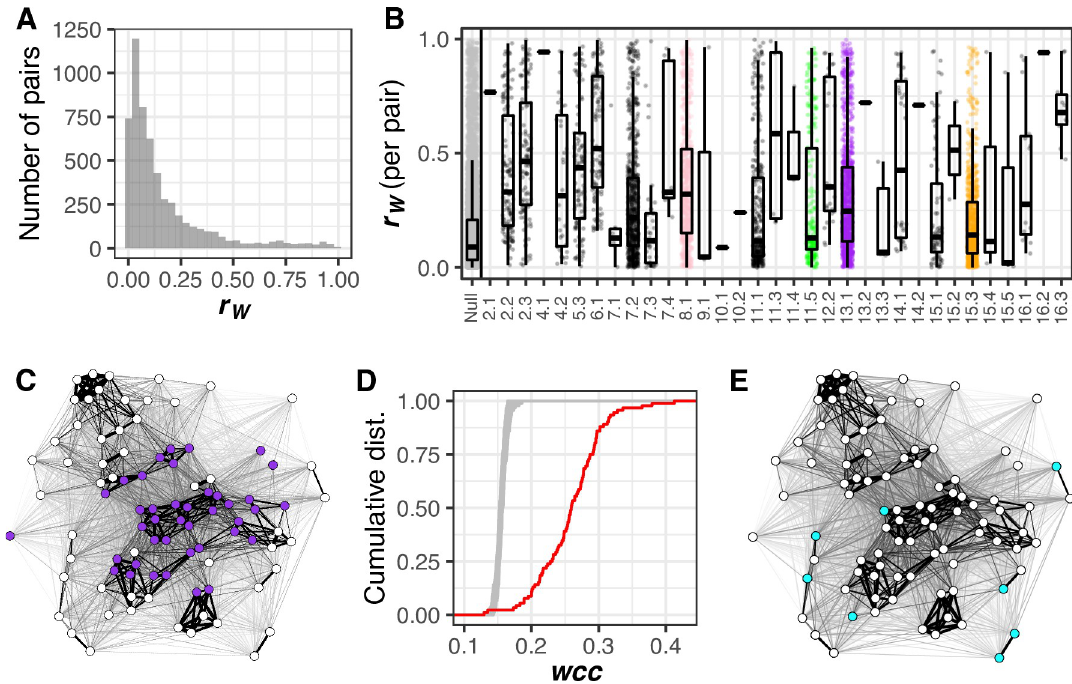
Fig 2. Pairs of traits with high correlation across clones are overrepresented among those influenced by pleiotropic QTL. Within- genotype correlations ( r W ) are calculated for 5,645 pairs of morphological traits. (A) Histogram showing distribution of r W . (B) Each point represents r W for a pair of traits. The null distribution displays r W for all 5,645 pairs of traits. Every other distribution displays r W for pairs of traits influenced by a single QTL. Horizontal axis labels represent the chromosome on which a QTL resides, followed by the order in which that QTL appears on the chromosome. Colored points correspond to those QTL highlighted in the same color in Fig 1A. Each box plot shows the median (center line), IQR (upper and lower hinges), and highest value within 1.5 × IQR (whiskers). (C) Force-directed network visualizing how pairs of morphological features correlate across clones. Each node represents a single-cell morphological trait measured in large-budded cells. For networks representing traits from unbudded and small-budded cells, see S4 Fig. The thickness of the line connecting each pair of nodes is proportional to r W . Node position in the network is determined using the Fruchterman-Reingold algorithm. Purple nodes correspond to traits influenced by a QTL on chromosome 13 containing the HOF1 gene. (D) Cumulative distributions (“dist.”) of weighted clustering coefficients ( wcc ) in a network created using measured values of r W (red line) or in 100 permuted networks (gray lines) for traits corresponding to large-budded cells. Permutations were performed by sampling r W , without replacement, and reassigning each value to a random pair of traits. For distributions summarizing wcc in networks representing traits from unbudded and small-budded cells, see S4 Fig. (E) The same network as in (C), with colored nodes corresponding to traits influenced by the leftmost QTL on chromosome 15. Data underlying this figure can be found at https://osf.io/ b7ny5/. IQR, interquartile range; QTL, quantitative trait loci.